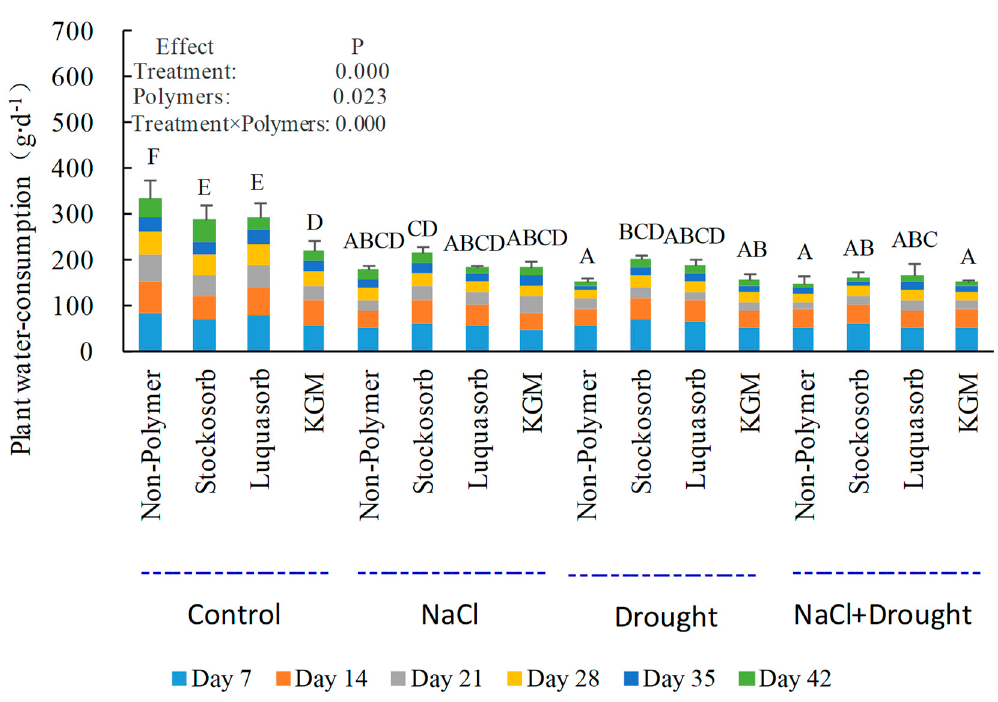
Figure 4. Effect of drought and salt stress on whole-plant water consumption in Metasequoia glyptostroboides seedlings. Columns show samples amended with synthetic (Stockosorb, Luquasorb) and natural (Konjac glucomannan, KGM) hydrophilic polymers and those not amended (Non-Polymer). Whole-plant water loss was measured after 7, 14, 21, 28, 35, and 42 days of salt and drought treatment. Each column represents the mean of three to five individual plants and bars represent the standard error of the mean. Columns labelled with different letters (A–F) are significantly different at the p < 0.05 level.